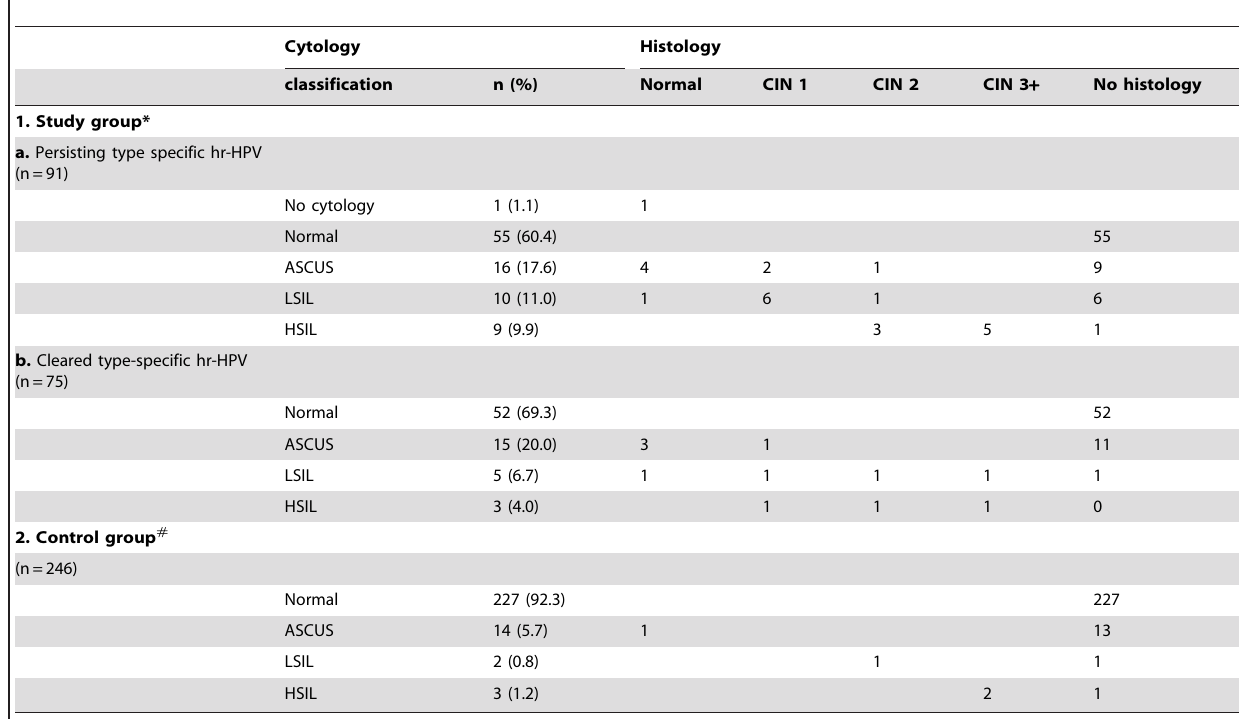
Table 6. Histo- and cytopathology follow-up